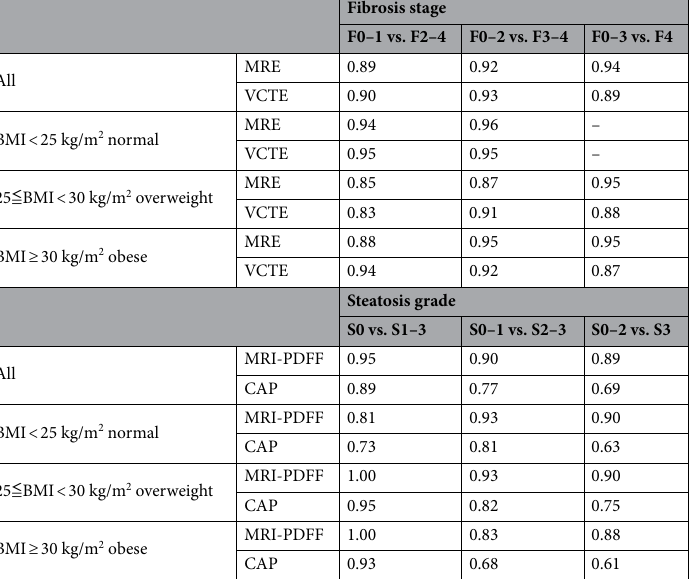
assessment of liver steatosis in the total group, normal ≥ 1 and 2, and overweight ≥ 1. As the BMI increased, the difference between the CAP and MRI-PDFF became more considerable (Fig. 5).